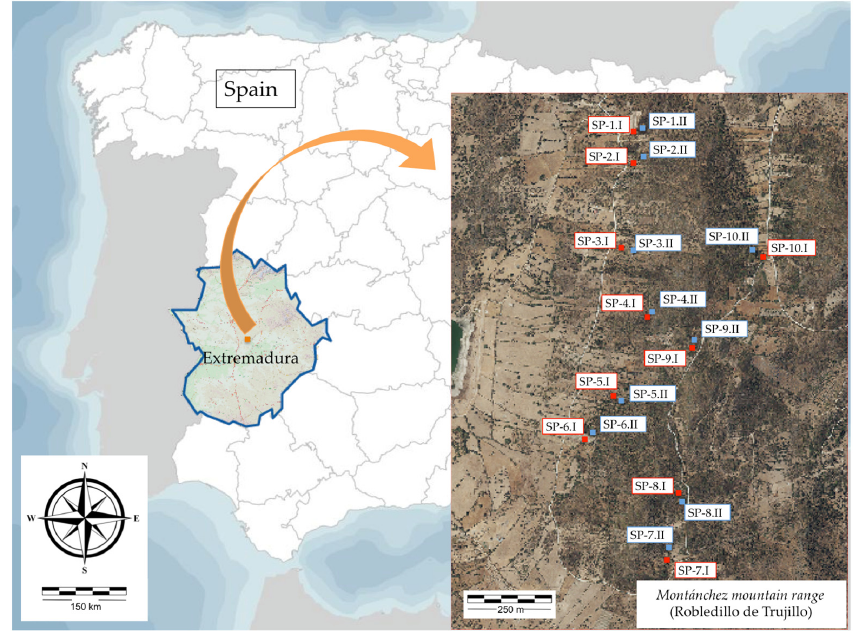
Figure 1. Study area and sampling points (SP). I: location considered permanent cultivated soil (CS); II: location considered abandoned agricultural soil (AS). Satellite image SIGPAC (2020). (Source: images gathered from IDEE and own source).